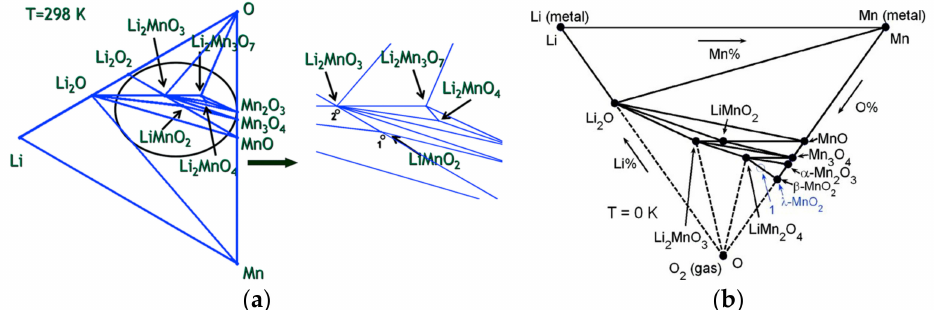
Figure 2. Calculated phase diagram of: Li-Mn-O system at room temperature (Reproduced from [47] with permission from the PCCP Owner Societies.) ( a ); and Li-Mn-O 2 at 0 K (Reproduced with permission from [12], Copyright 2007, American Chemical Society) ( b